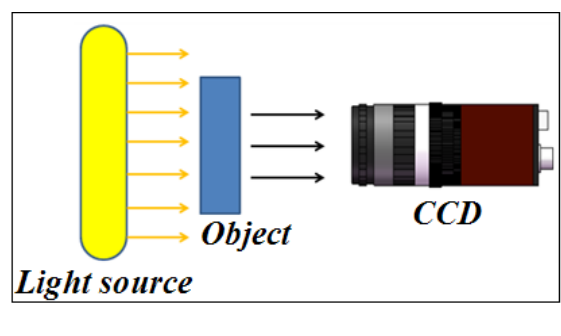
Figure 4. “Back light source”.